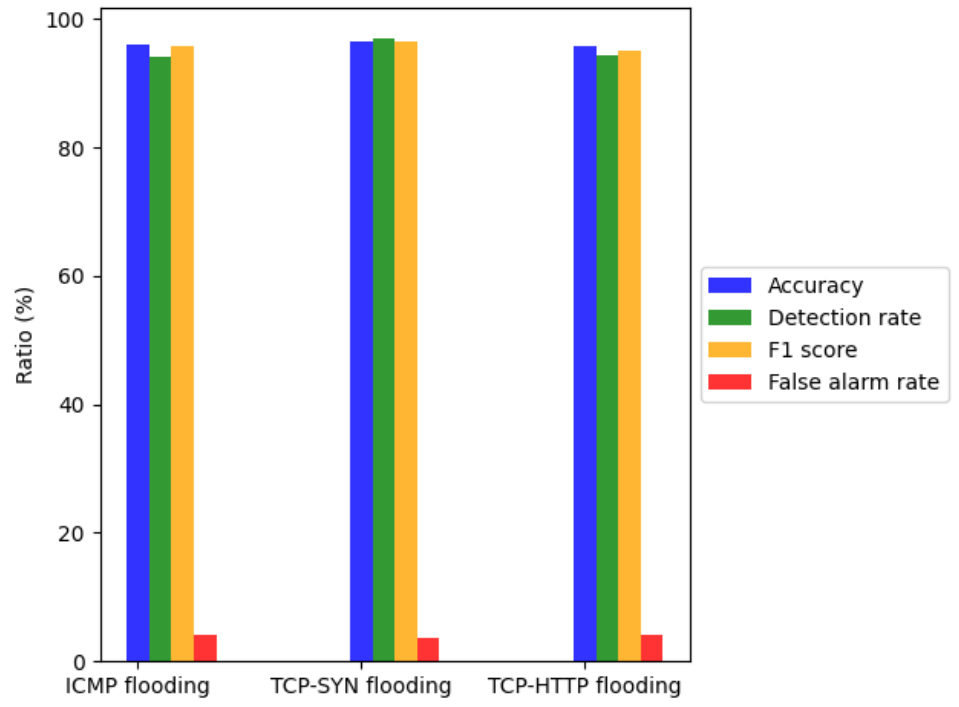
Figure 8. Detection performance of the period detector in different kinds of EDoS